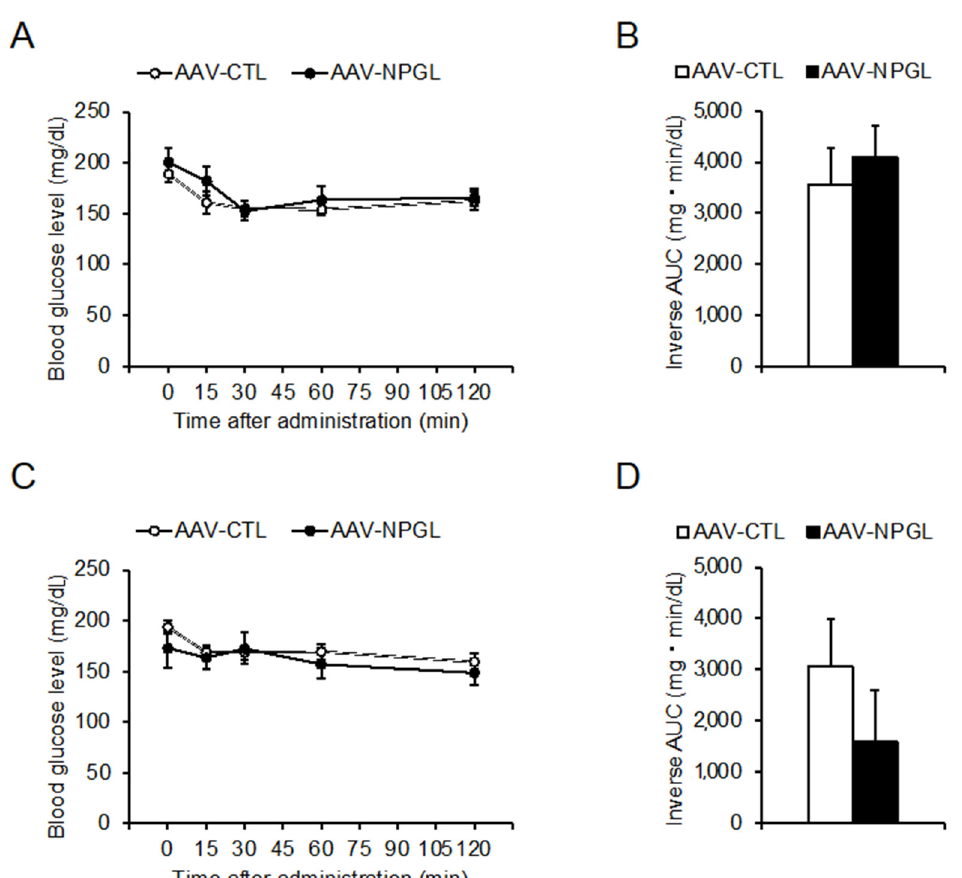
Figure 3. Effects of Npgl overexpression on insulin sensitivity in mice fed a high-fat diet with 60% calories from fat (HFD 60). These mice were injected with an adeno-associated virus (AAV) vector, either a control (AAV-CTL) or a vector carrying the NPGL precursor gene (AAV-NPGL). ( A – D ) Results of intraperitoneal insulin tolerance test (IPITT) at multiple time points in HFD 60-fed mice tested 5 weeks ( A , B ) and 17 weeks ( C , D ) after surgery. ( A , C ) Blood glucose levels. ( B , D ) Inverse area under the curve (AUC) for blood glucose levels. Statistical analyses were performed using two-way repeated measures ANOVA followed by Bonferroni’s test ( A , C ) or Student’s t -test ( B , D ). Each value represents the mean ± standard error of the mean (AAV-CTL: n = 8, AAV-NPGL: n = 8).